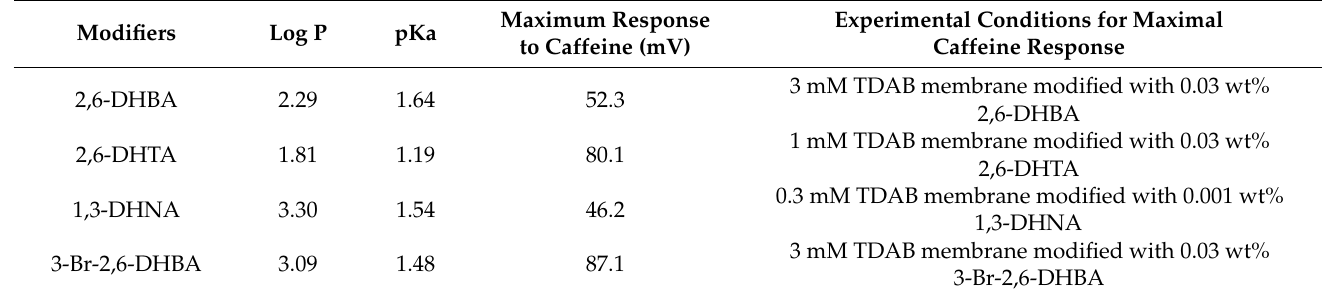
Table 4. Log P and pKa of 2,6-DHTA, 1,3-DHNA, and 3-Br-2,6-DHBA; maximum response to caffeine obtained from each